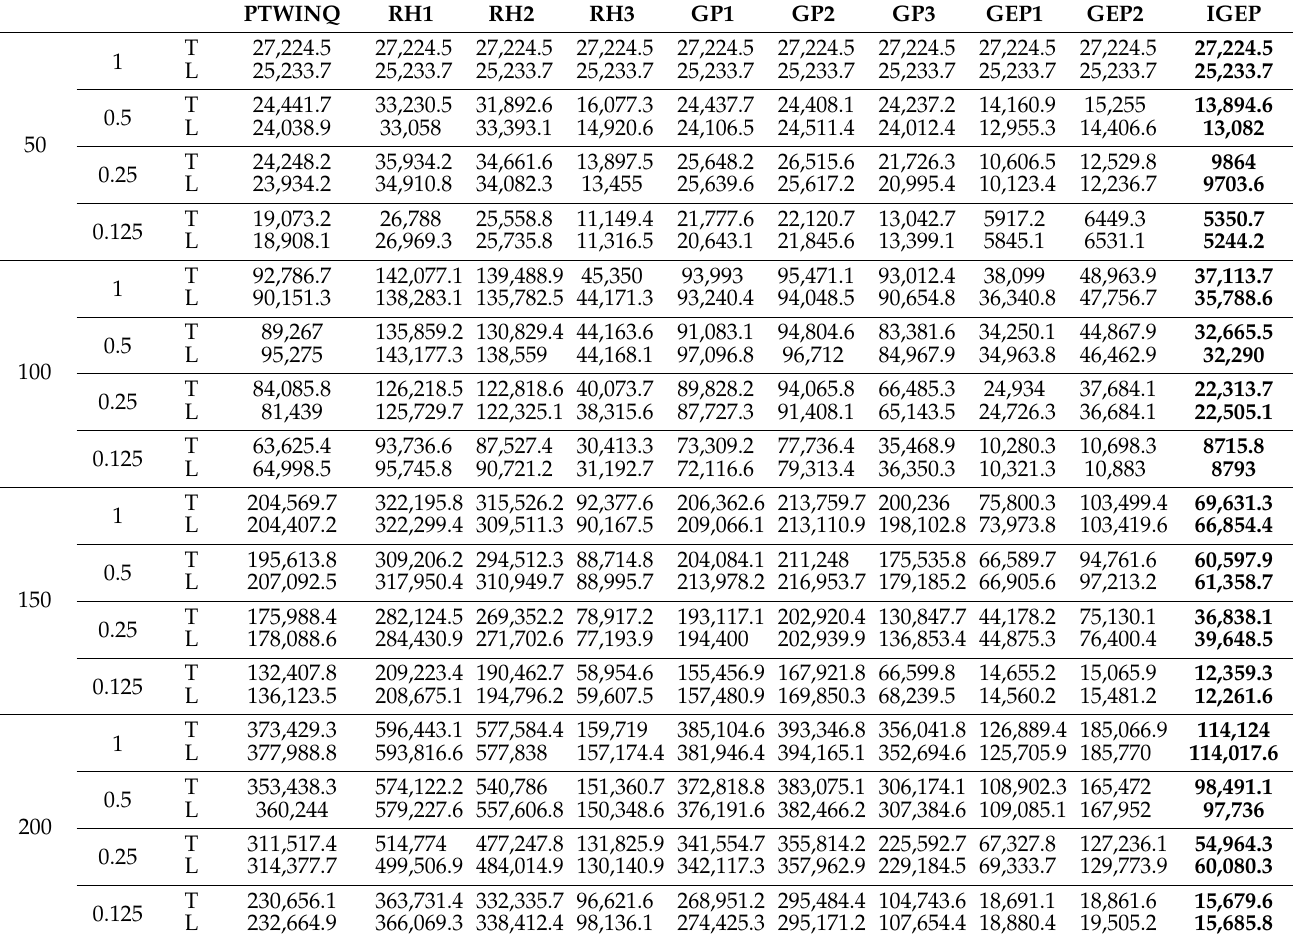
Table 2. Comparison of discovered/combination rules with minimum total flow time.